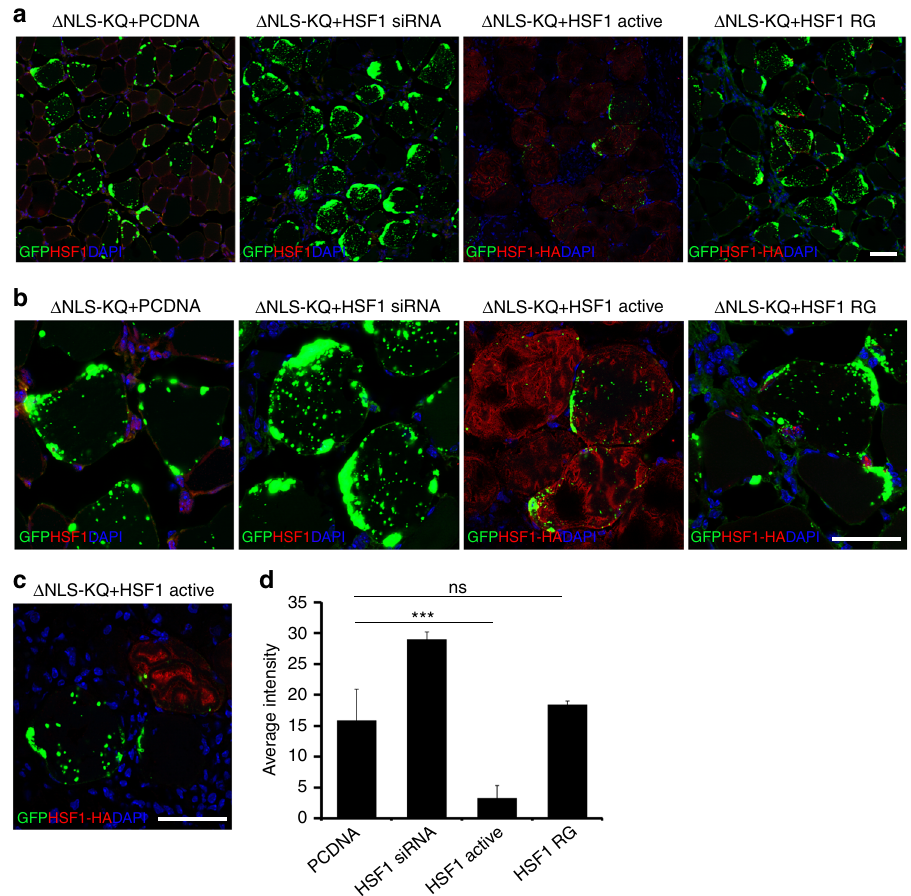
Fig. 7 An HSF1-dependent cascade suppresses TDP-43 acetylation-mimic-induced pathology in vivo in skeletal muscle. a Immuno fl uorescence analysis was performed on TA muscles co-electroporated with GFP-tagged TDP-43- Δ NLS-K145Q in combination with either control vector (pCDNA), an HSF1-speci fi c siRNA, active HSF1 or inactive HSF1 (R71G) for 4 days. b Higher magni fi cation ×40 images of muscles described in a are shown. Reduced levels of aggregated TDP-43 were observed in the presence of active HSF1 (red). c Adjacent myo fi bers in the presence ( red ) or absence ( white asterisk ) of active HSF1 are depicted. Reduced levels of aggregated TDP-43 were observed in the myo fi ber expressing active HSF1. d TDP-43 average aggregation intensity was quanti fi ed among the total HSF1-expressing muscle fi bers. Error bars represent SEM, and the triple asterisk indicates statistical signi fi cance with *** p -value < 0.001 as measured by Student ’ s t -test from N = 3 biological replicates. ns = not signi fi cant. Scale bar = 50 μ